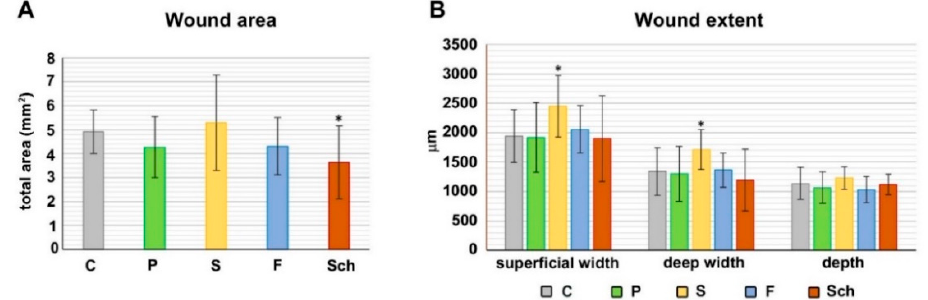
Figure 2. Extent of the wound was measured on transversal histological sections stained by Hematoxylin-Eosin. Control (C), palm oil (P), safflower oil (S), fish oil (F) and Schizochytrium extract (Sch) treated animals were analyzed 12 days after skin excision. ( A ): Total wound area. ( B ): Wound extents at different aspects. * labeled group of fatty acids differ significantly from the control group ( p < 0.05; unpaired t -test; n = 10), average values and standard deviations are displayed in both graphs.